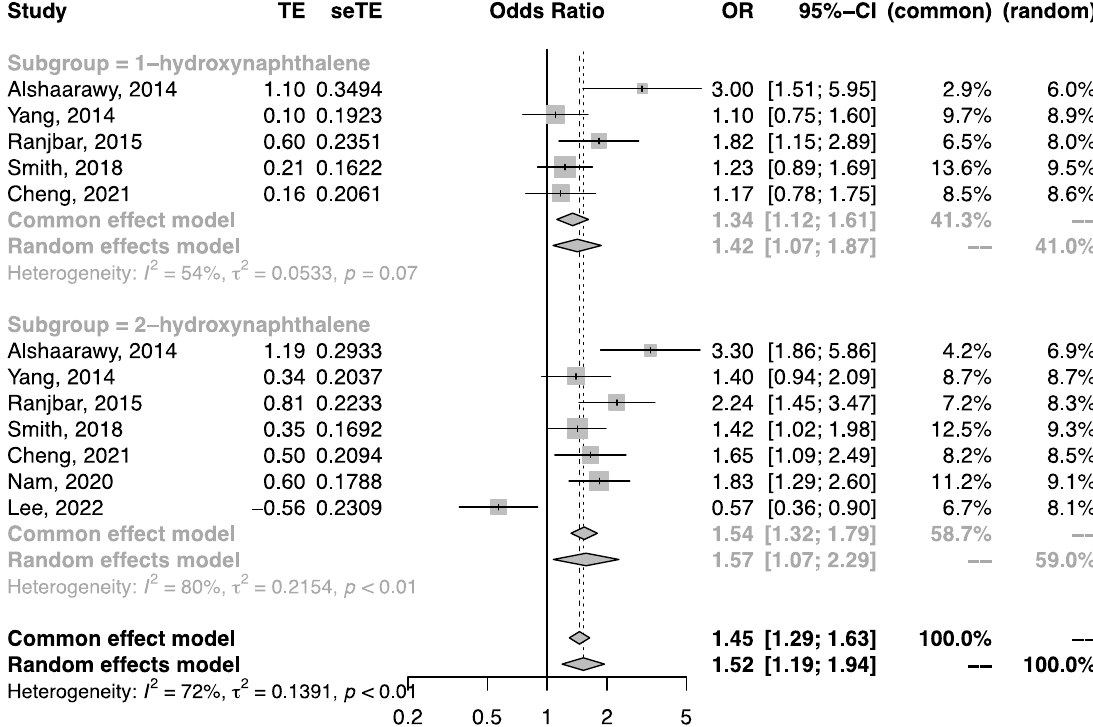
Figure 3. The association between urinary FLU metabolites and risk of T2DM [20–25,28].